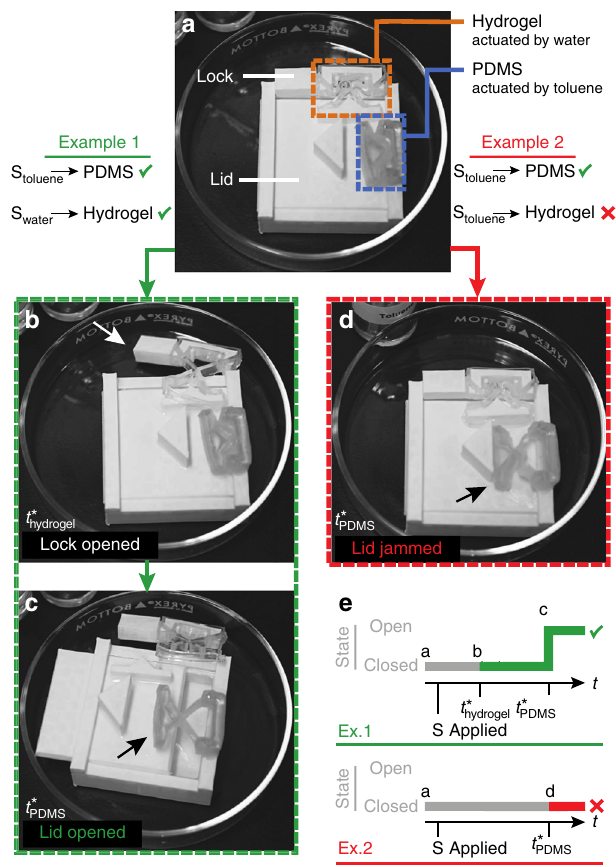
Fig. 6 Multimaterial responsive systems, e.g., Open (S water ∧ S toluene | t (cid:4) < t (cid:4) ). a A box with a lid which is unlocked upon actuation of a PDMS hydrogel hydrogel-based unit (at time t (cid:4) ) and subsequently opened upon hydrogel actuation of a PDMS-based unit (at time t (cid:4) ). b , c Example 1: if water is PDMS applied to the hydrogel-based unit and toluene to the PDMS-based unit, the lid is unlocked and then pushed open, successfully opening the box (Supplementary Movie 12). d Example 2: if toluene is applied to both